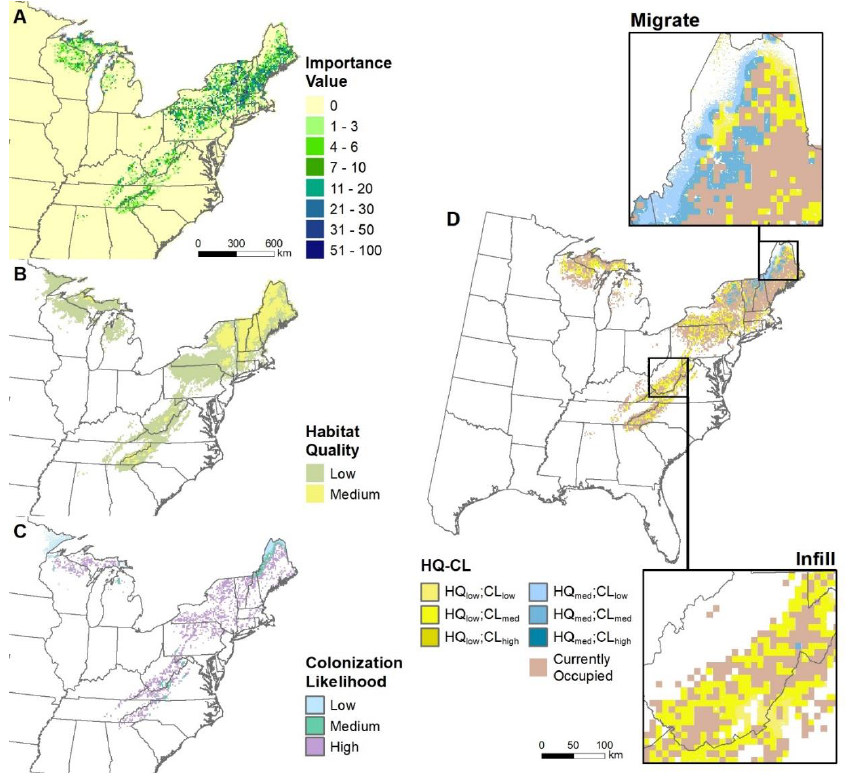
Figure 5. Process flow to intersect HQ and CL for eastern hemlock. ( a ) Current importance value of hemlock as determined by FIA data; ( b ) habitat quality (HQ) at RCP 8.5, year 2100, reclassed into low, medium, high HQ (there was no high HQ for hemlock), at a resolution of 10 × 10 or 20 × 20 km; ( c ) colonization likelihood (CL) into RCP 8.5 habitat, and reclassed into low, medium, high CL, at a resolution of 1 × 1 km; ( d ) combination of ( a – c ), yielding locations with null to high CL on top of low to medium HQ, as well as currently occupied cells; (infill inset) detail of locations where infilling is primary; (migrate inset) detail of locations where migrating is primary.